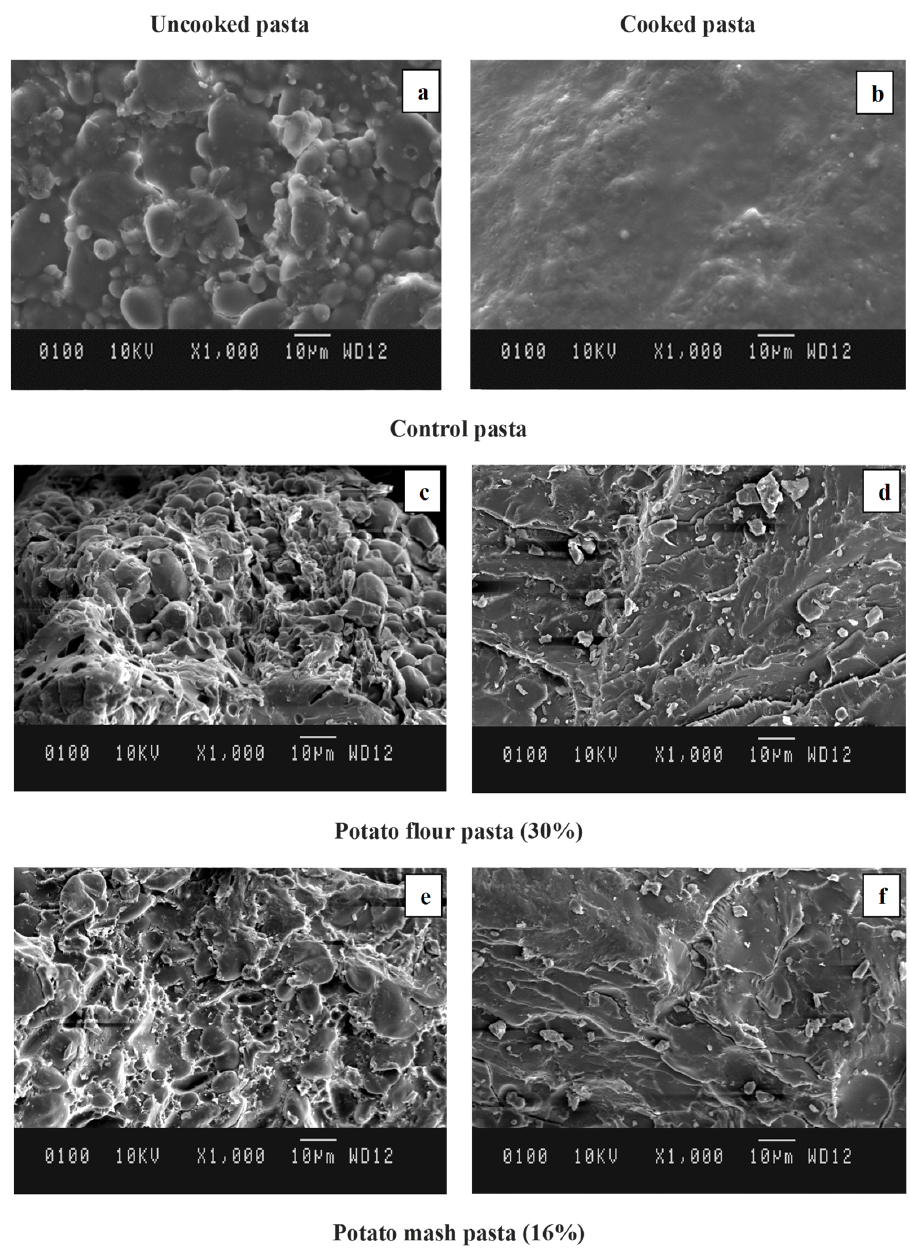
Figure 2. Scanning electron microscopic images of uncooked ( a , c , e ) and cooked ( b , d , f ) control, potato flour and potato mash pasta.